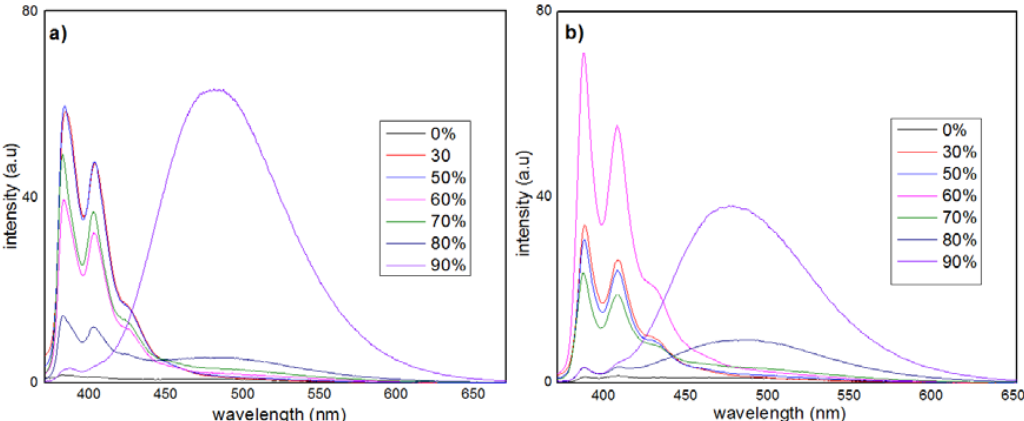
Figure 4. Emission spectra of ( a ) mTPEP and ( b ) pTPEP in THF/water mixtures at excitation wavelengths of 355 nm and 333 nm, respectively. The concentration of solution is 10 µM.